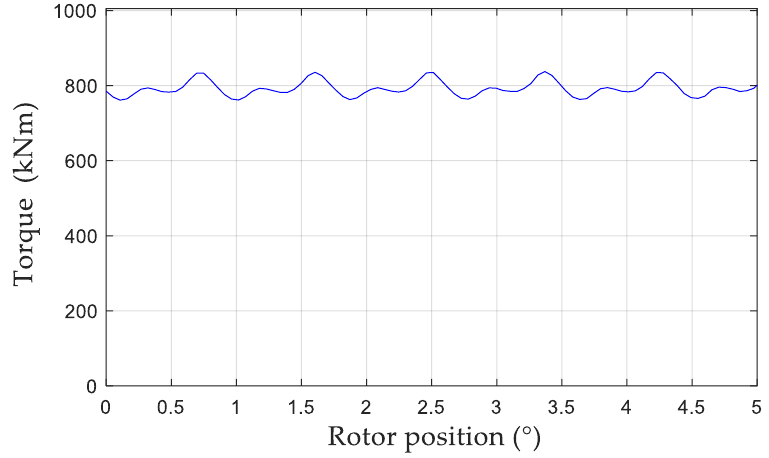
Figure 14. Torque evolution with rotor position at full power obtained by the FEA.